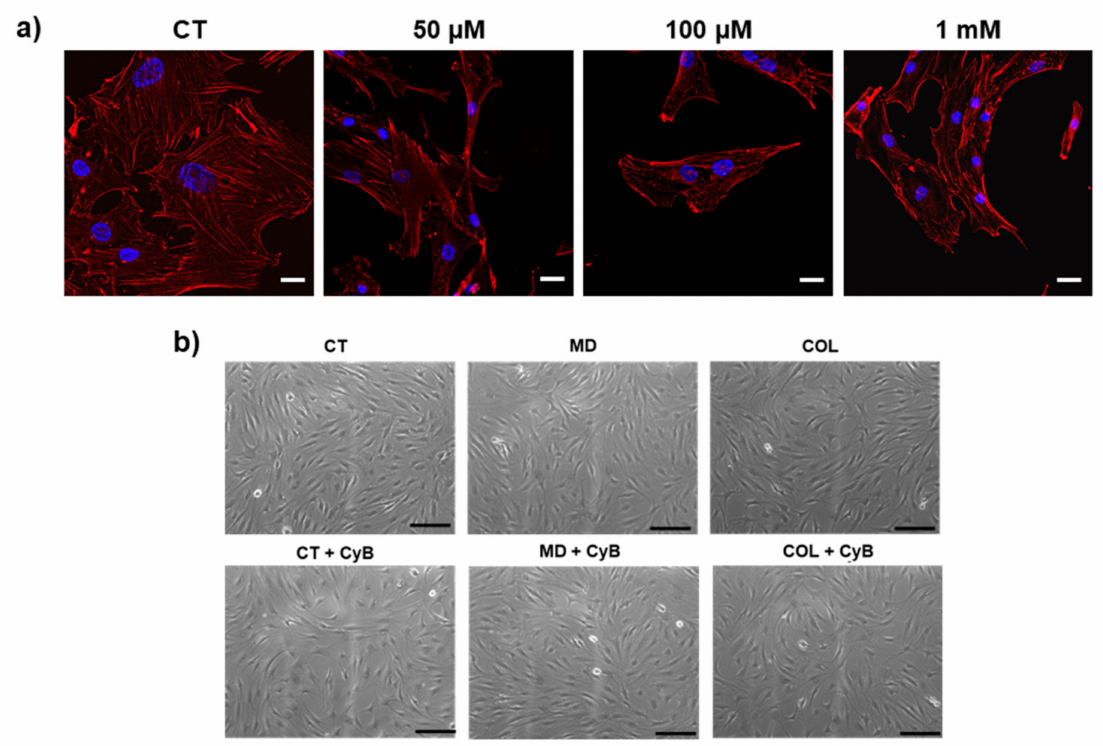
Figure 5. ( a ) Micrographs showing actin filaments detected by rodhamine-phalloidin by THUNDER in control cells (CT) and after administration of CyB at the indicated doses. After 50 µ M CyB, actin filaments become shorter and more evident, indicating that the cytoskeleton is not preserved after CyB. ( b ) Representative phase contrast microscopy micrographs showing cell morphology of cells grown on MD and COL, compared to CT. After CyB, CT cells become less flattened and more rounded (Figure 4b). Scale bar 200 µ m ( a ) and 20 µ m ( b